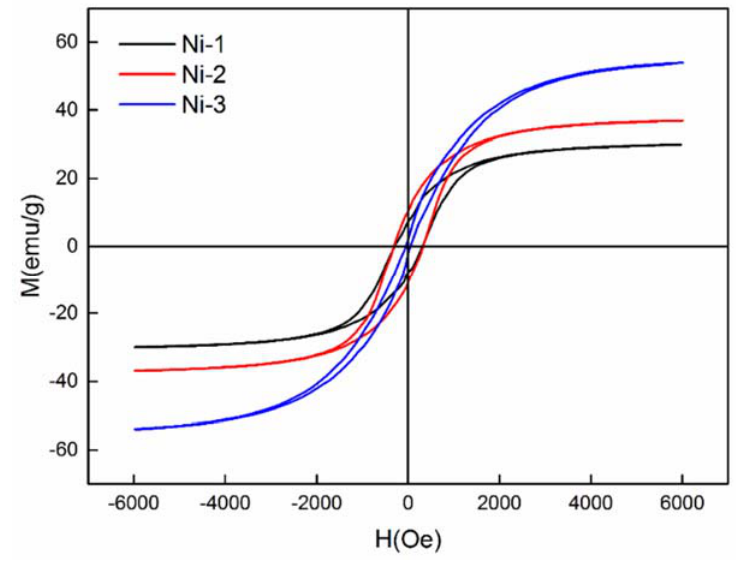
Figure 5. Magnetic hysteresis loop of nanoporous Ni with different plating times at 35 °C. Table 2. Saturation magnetization (Ms), remnant magnetization (Mr), and coercivity (Hc) of the nanoporous Ni with different electroless plating times at 35 °C and bulk Ni.